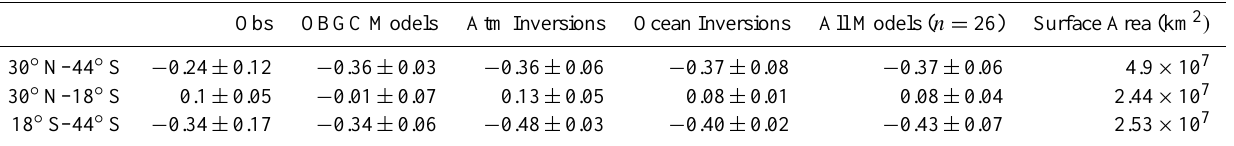
Table 3. The annual multi-model median uptake (negative into the ocean) and median absolute deviation (MAD) from ocean biogeochemical models, atmospheric and ocean inversions, observations and all of the models. All units are PgCyr − 1 .